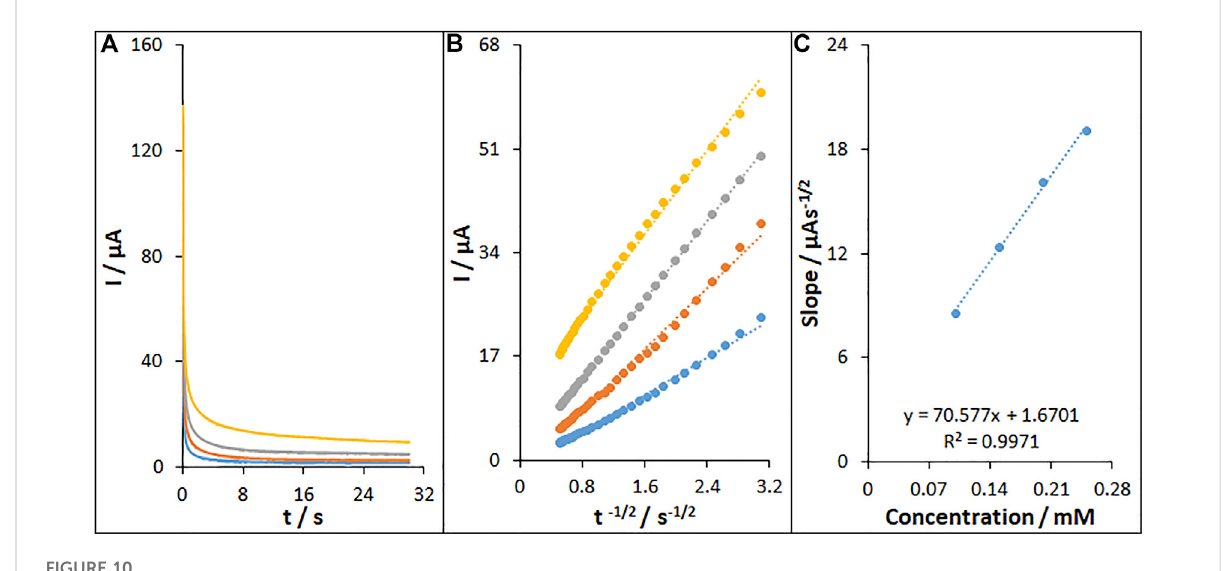
FIGURE 10 (A) Chronoamperograms offentanylon MWCNT/HG-NiO-ND/PGE in0.1 MPBS (pH7.0)for differentconcentrationsof fentanyl. The numbers 1 – 4 correspond to 0.1, 0.15, 0.2, and 0.25 mM of fentanyl, respectively. (B) Plots of I vs. t − 1/2 obtained from chronoamperograms 1 – 4. (C) Plot of the slope of the straight lines against fentanyl concentration.